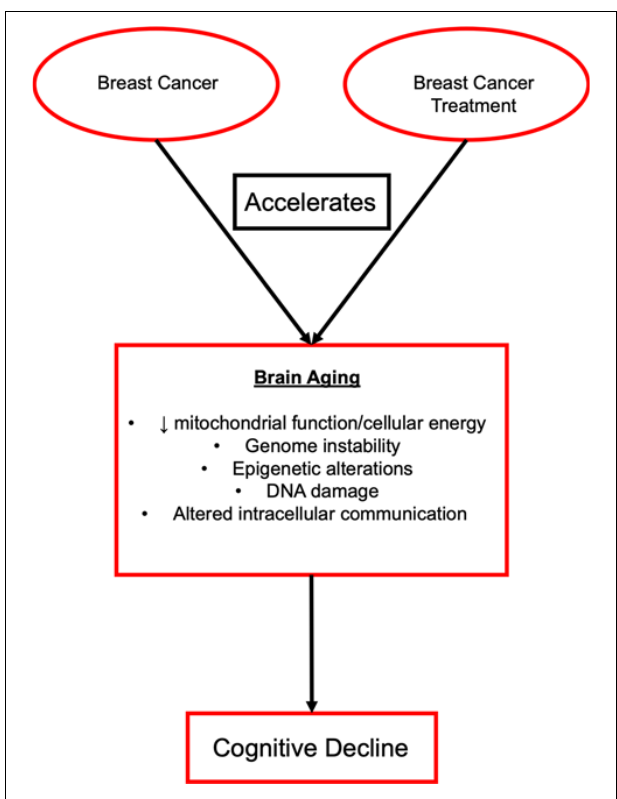
FIGURE 1 | Effects of breast cancer and breast cancer treatment on brain